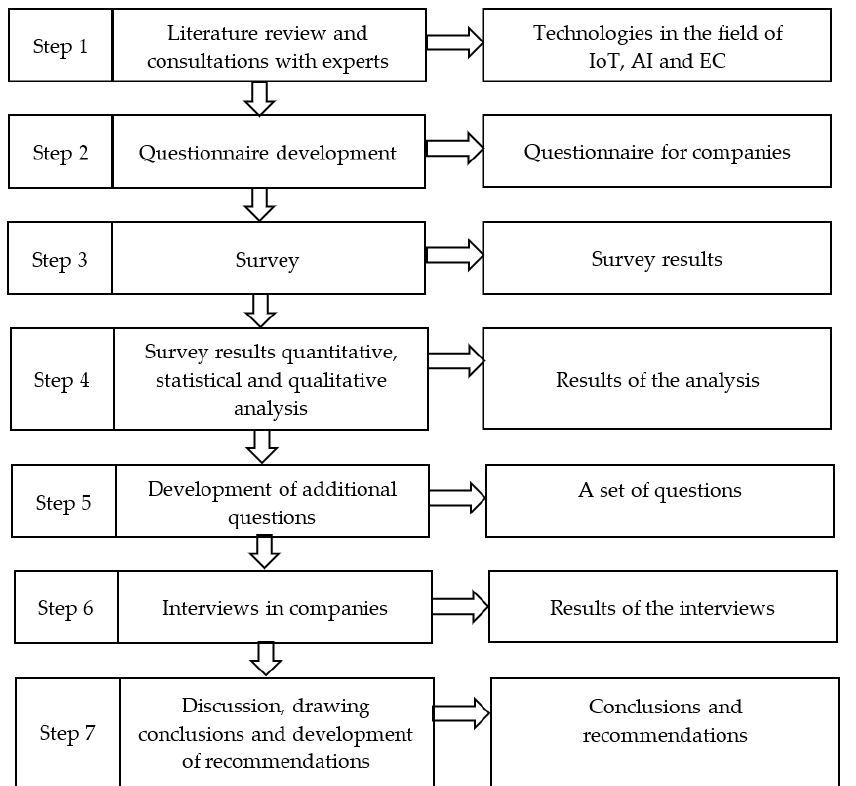
Figure 1. Work methodology.